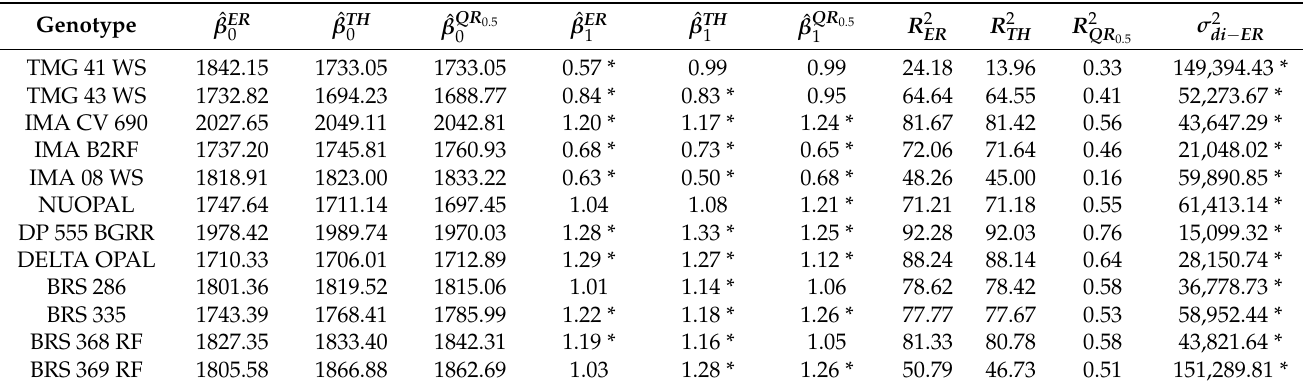
Table 4. Estimate of adaptability and stability parameters by the Eberhart and Russell (1966), non-parametric and quantile regression methodologies of yield of 12 early cotton genotypes (synthetic data).